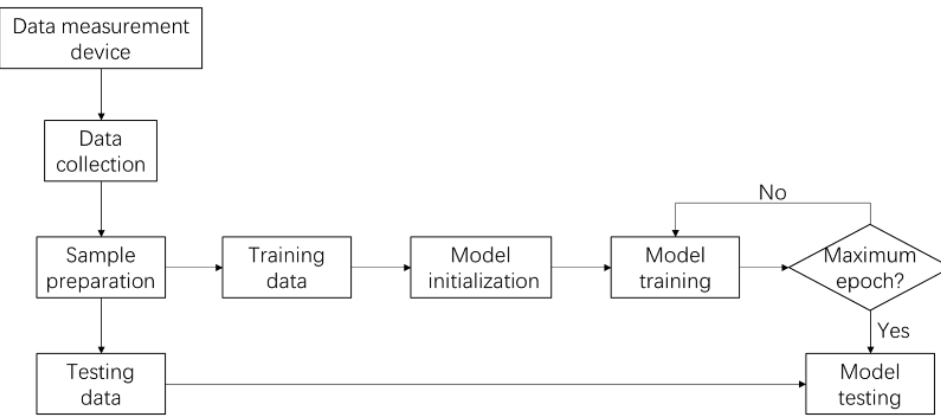
Figure 2. The general flow chart for our proposed method.